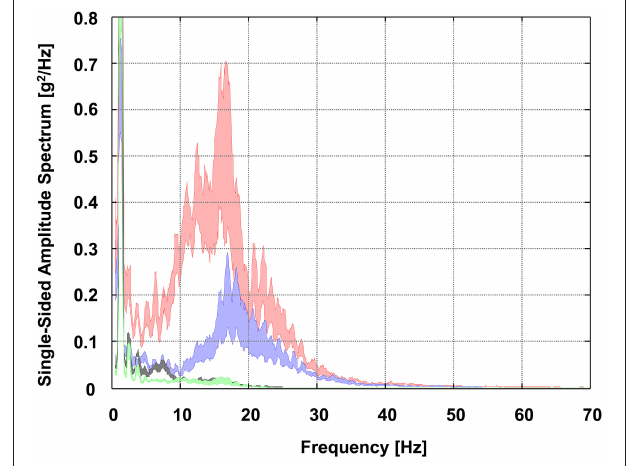
FIGURE 3 | Group average power spectral density (PSD) curves of all segments in GS skiing visualized as the area of uncertainty around the estimate of the mean ( ± SE). Red, right shank sensor; blue, right thigh sensor; gray, sacrum sensor; green, sternum sensor.